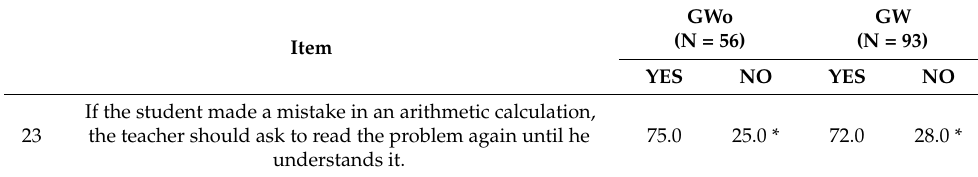
Table 6. Percentages of responses of knowledge of stuck state in